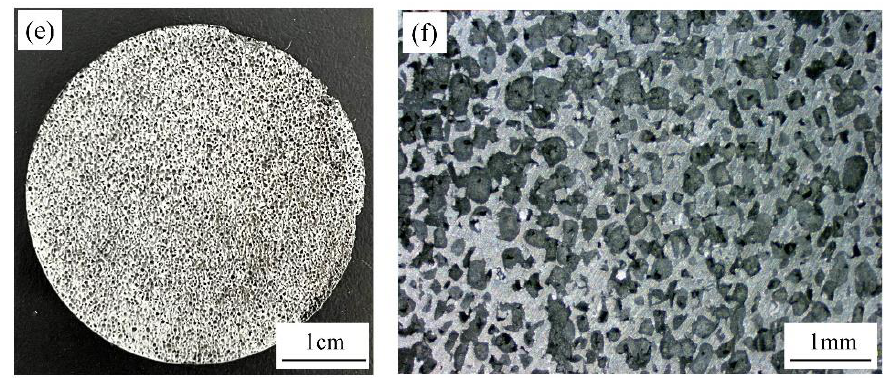
Figure 11. Macroscopic morphologies of porous materials with different contents of NaCl space holder ( a , b ) 50 vol.%; ( c , d ) 60 vol.%; ( e , f ) 70 vol.%.